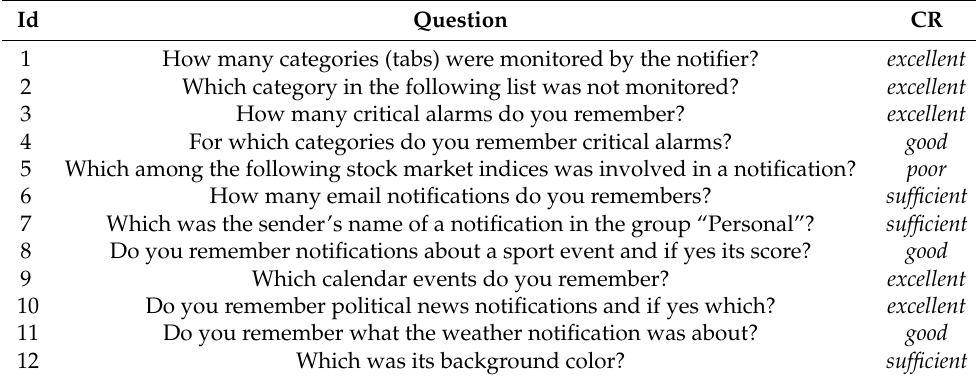
Table 8. Results of the secondary task of the dual tasks